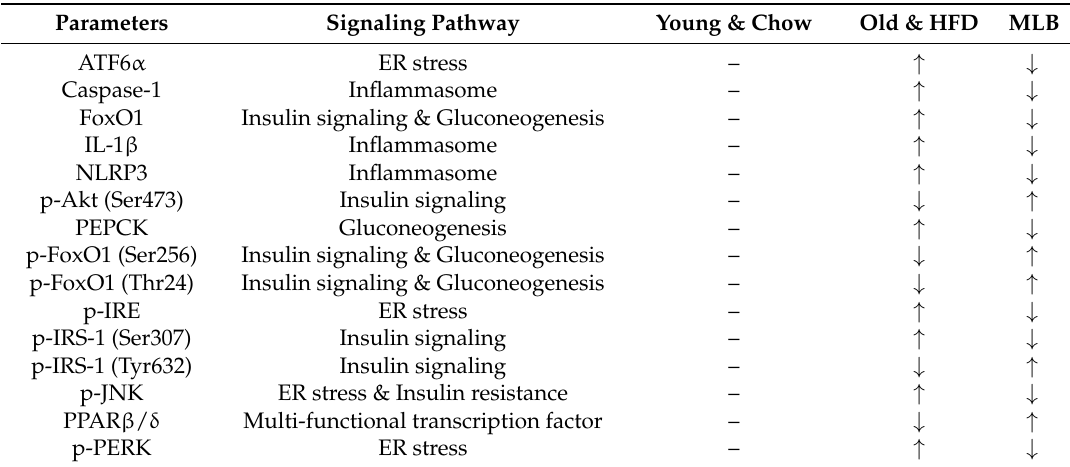
Table 1. Summary of aging, obesity, and MLB actions in the